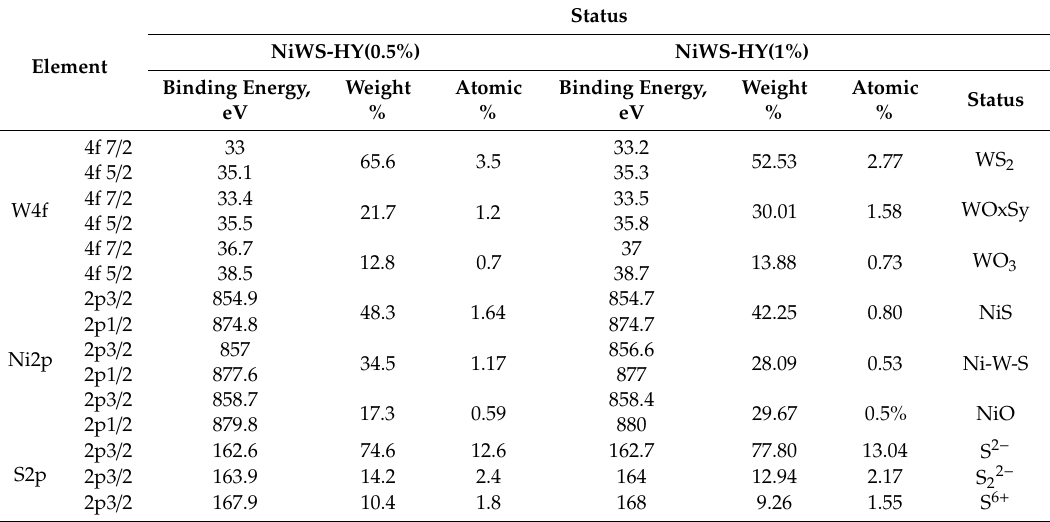
Table 4. XPS data for W4f, Ni2p, and S2p levels (catalyst obtained by decomposition of precursors with di ff erent concentrations of added zeolite) are 0.5% and 1%-HY in standard conditions.